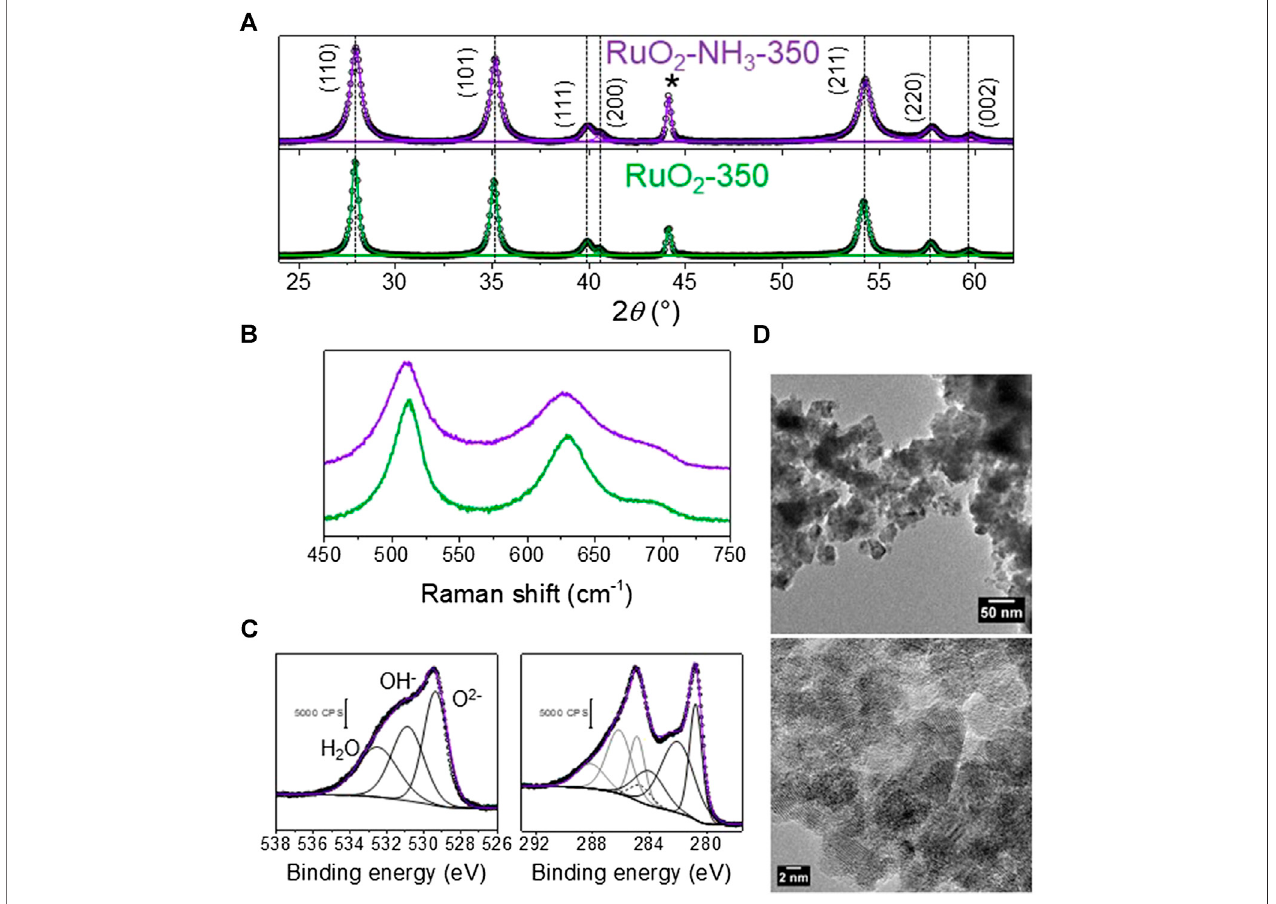
FIGURE 6 | (A) XRD pattern of C-RuO 2 (green lines) and A-C-RuO 2 (purple lines) (*sample holder), peak position of C-RuO 2 are shown as dashed lines for comparison to that of A-C-RuO 2 ; (B) Raman spectra C-RuO 2 (green line) and A-C-RuO 2 (purple line); (C) XPS Ru 3d and O 1s core level spectra of A-C-RuO 2 sample (the C 1s component of the signal in the Ru 3d core level spectrum is presented with a dashed line); (D,E) TEM image and HRTEM image of A-C-RuO 2 .